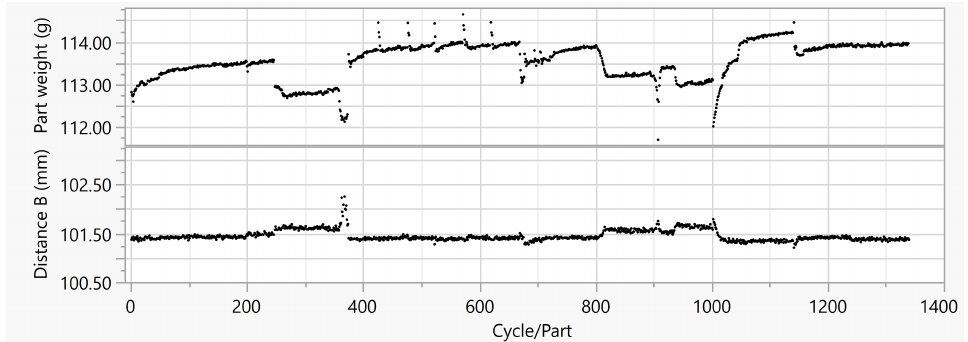
Figure 7. Part weight, Distance B vs. cycle or part in Stacking Box Data Set